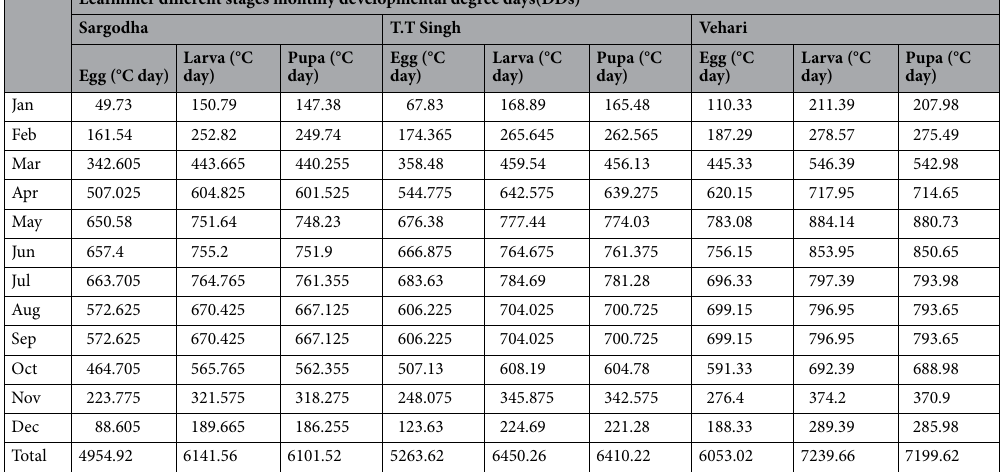
Table 3. Leafminer developmental degree days